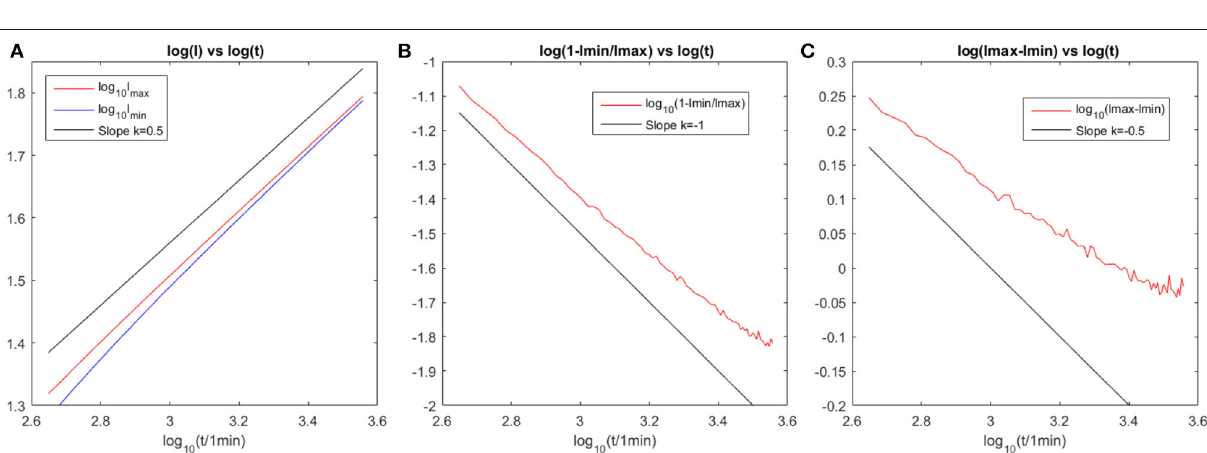
0.5 which implies that the curves tend to follow the = 1. (C) The difference of the = − = −